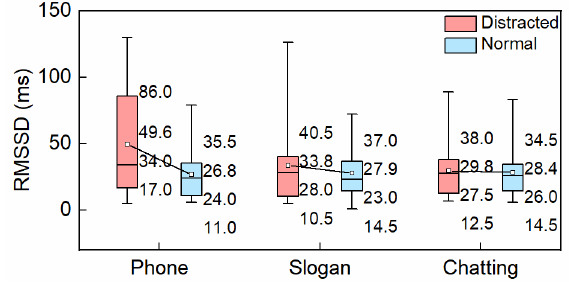
Figure 5. Figure 5. RMSSD.